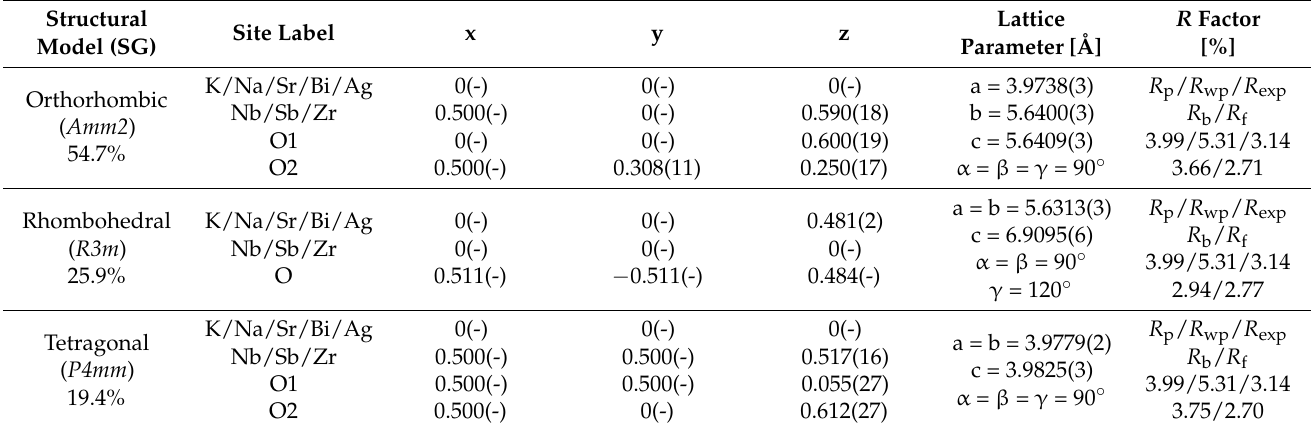
Figure 2a–e display the SEM images of the cross ‐ sectional fractured surface of the NKNS ‐ 0.02SZ ‐ 0.02BAZ + y mol% NN thick films (0.0 ≤ y ≤ 5.0). The untextured thick film ( y = 0.0) has randomly oriented grains with an average grain size of 7.4 μ m (Figure 2a). The grains begin to align along the [001] direction when 1.0 mol% NN seeds ( y = 1.0) was used for texturing, but many of the grains were randomly oriented, as indicated by the arrows shown in Figure 2b. For the thick film with y = 2.0, many of the grains were textured, but a few remain untextured, as indicated by the arrows in Figure 2c, implying that the thick films ( y = 1.0 and 2.0) have not been completely textured, although they show relatively large LF values close to 95%. All grains were well textured in the thick film with y = 3.0 (Figure 2d). The average grain size of this thick film was ~23 μ m, implying that the NN seeds align the grains as well as increasing the grain size in the thick films.